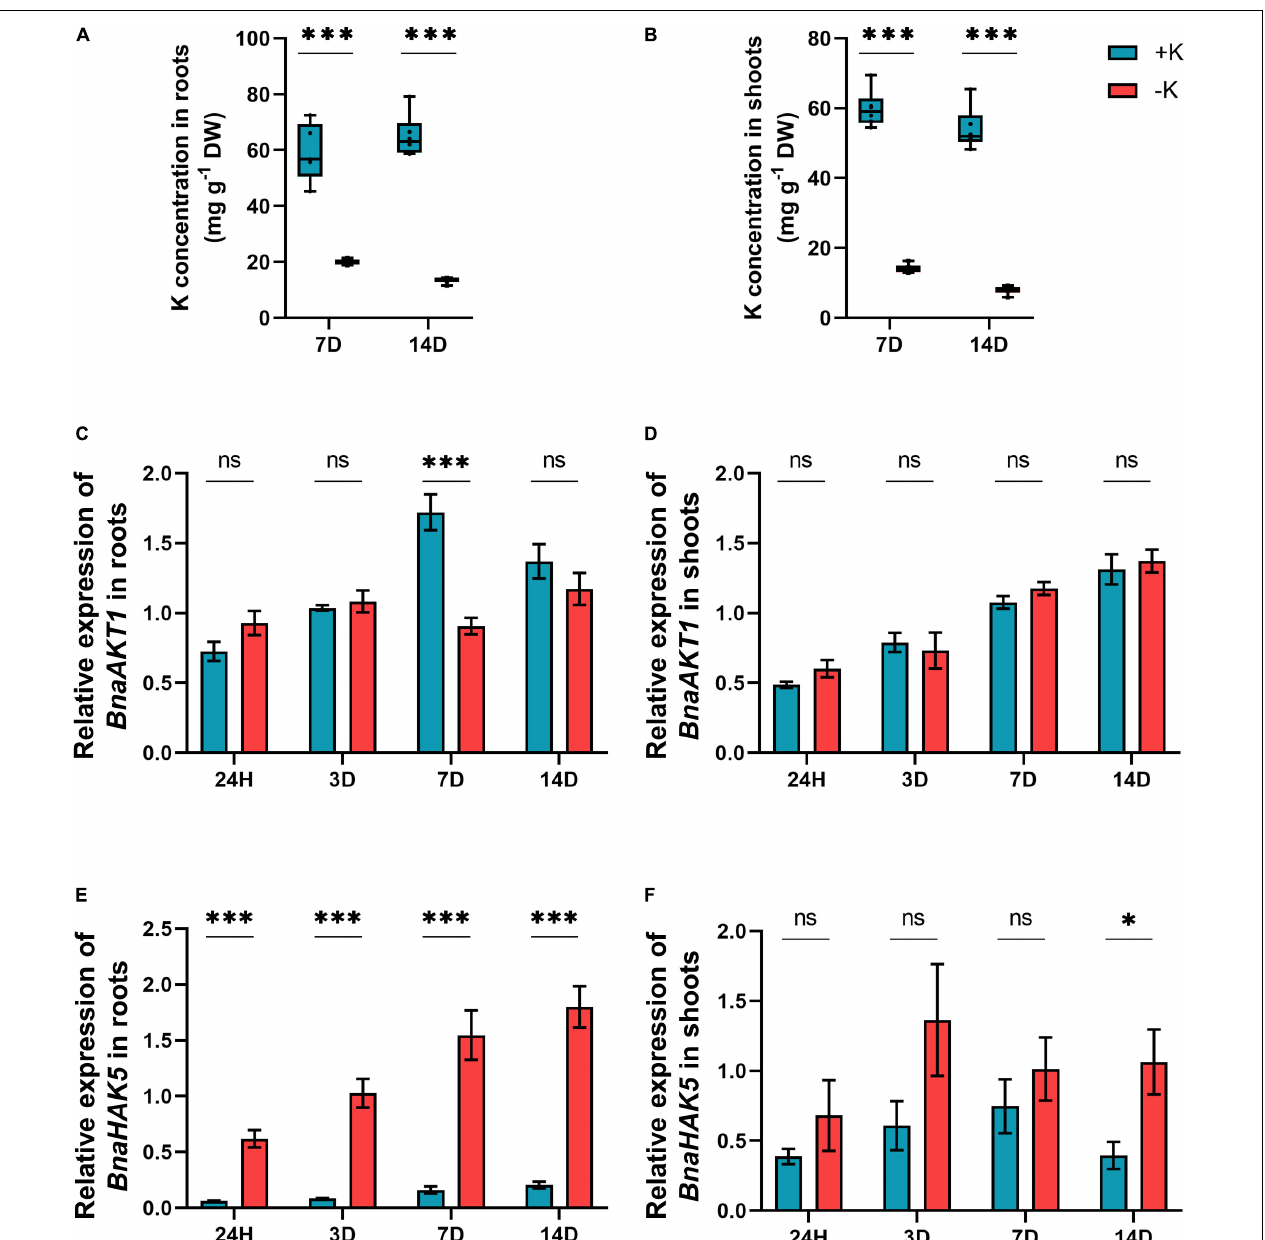
FIGURE 2 | Influence of K deficiency on K concentration and the expression of the genes involved in K transport in rapeseed plants. (A) K concentration in roots; (B) K concentration in shoots; (C) relative expression of BnaAKT1 in roots; (D) relative expression of BnaAKT1 in shoots; (E) relative expression of BnaHAK5 in roots and (F) relative expression of BnaHAK5 in shoots. Plants were grown in a hydroponic culture under either –K (0 mm) or + K (2 mm). Roots and shoots were harvested after 24 h, 3, 7, or 14 days of K deprivation. Bars indicate mean ± standard error of the mean (SEM) ( n = 6). Asterisks denote the significant level of the difference according to t -test ( ∗ p < 0.05, ∗∗ p < 0.01, and ∗∗∗ p < 0.001, n = 6). Ns denotes non-significant differences.